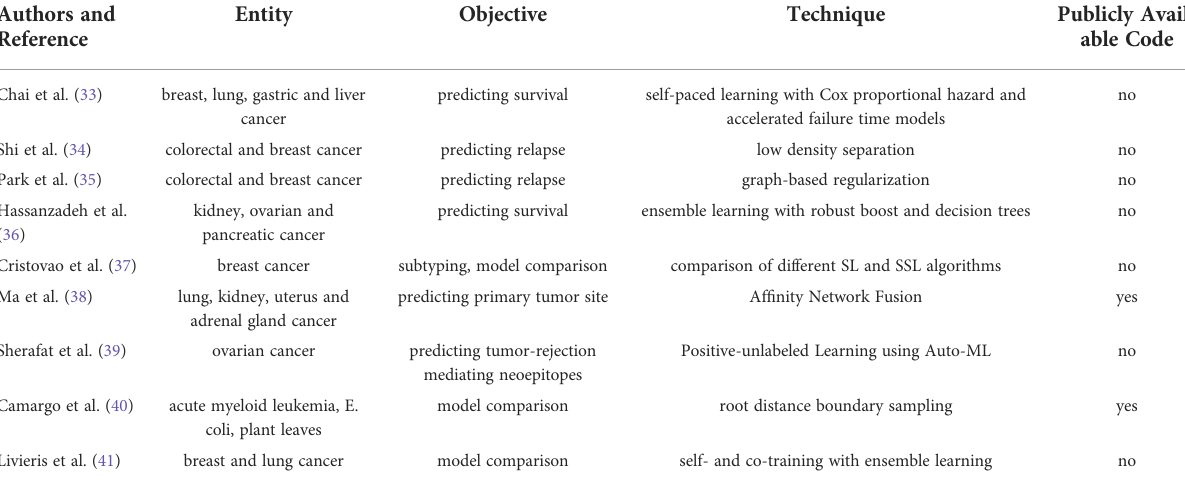
TABLE 3 Overview of Studies on Semi-Supervised Learning using non-image-based data. Authors and